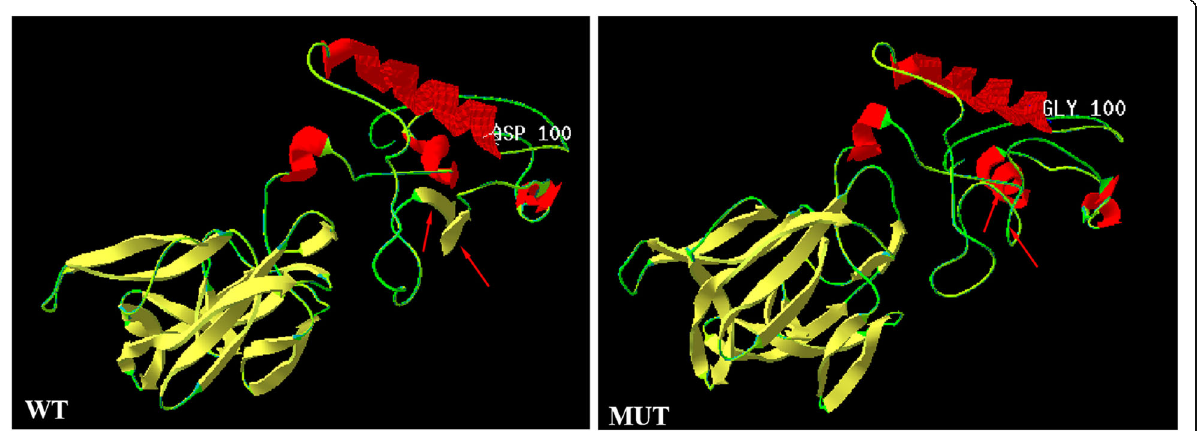
Fig. 5 Three-dimensional structure modeling predicted a decrease in the proportion of β -sheet regions, and an increase of random coil regions in mutant protein. The dimer alterations are indicated by an arrow. WT, wild-type; MUT,